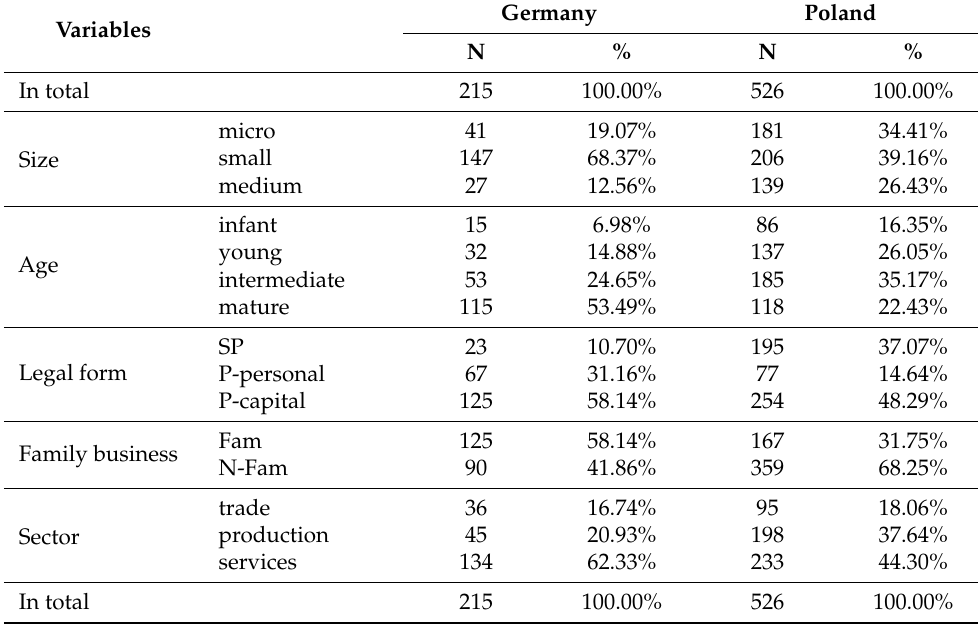
Table 5. Sample characteristics (business